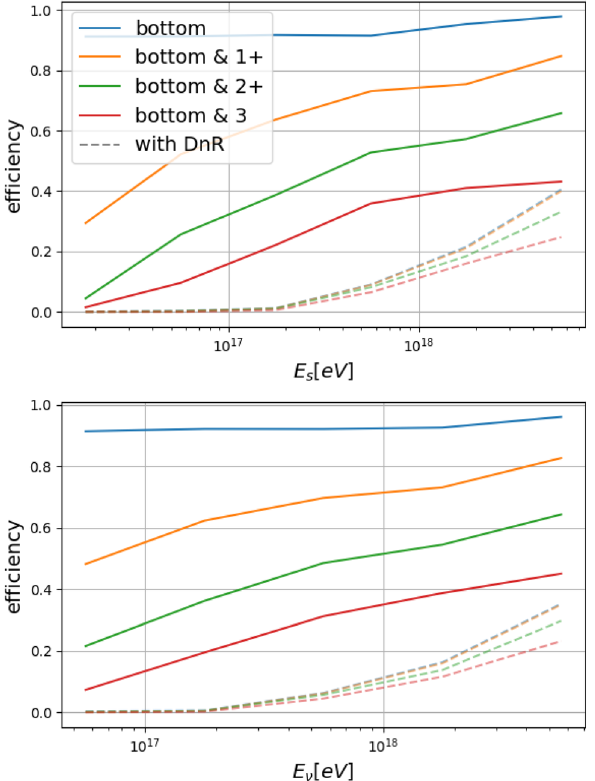
Fig. 10 Reconstruction efficiency based on a simplified trigger simu- lation. Probability for an event to have at least one channel with SNR > 2 . 5 in one of the channels at ∼ 100 m depth and to have SNR > 2 . 5 in the additional channels on the power string as well, as a function of shower energy (top) and neutrino energy (bottom). The dotted lines show the probability that at least one channel detected a second pulse that also has SNR > 2 . 5 the antenna has a relatively low sensitivity, as is the case for the Hpol antennas, thermal noise can be amplified and distort the result.